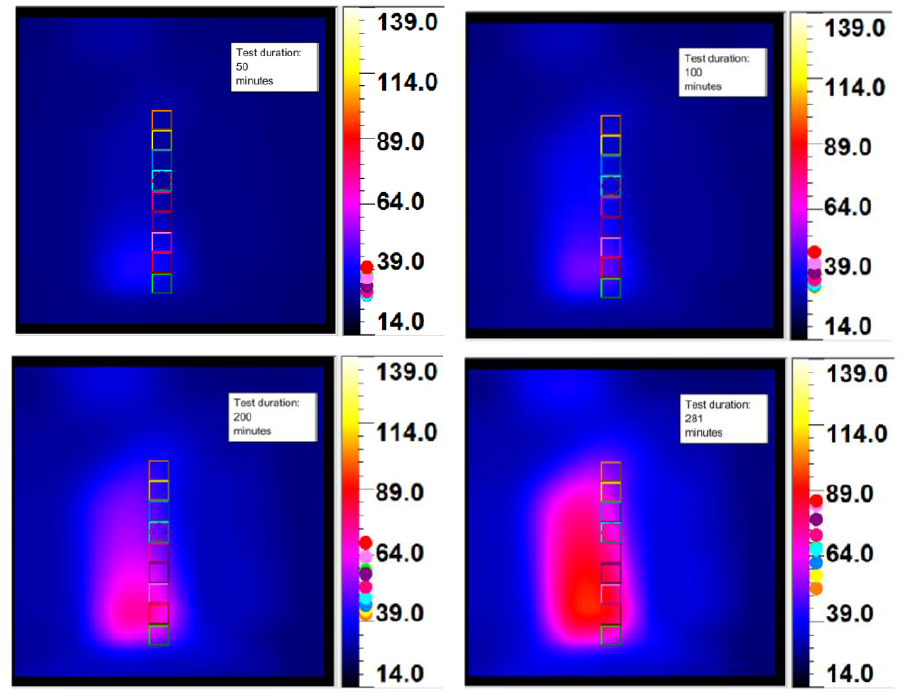
Figure 12. Temperature evolution for the LLC mix.